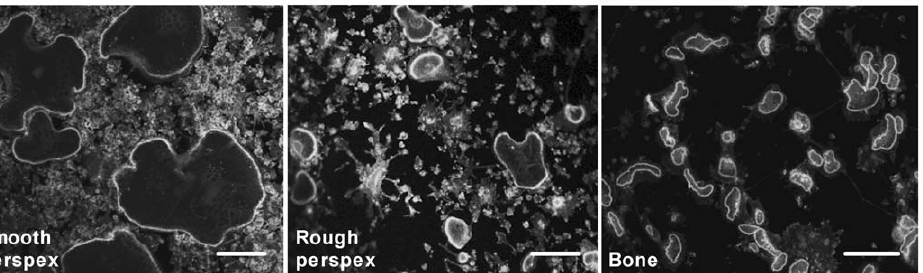
Figure 3. The effect of substrate roughness on the morphology of podosome belts. Bone marrow-derived osteoclasts were sedimented in MEM/BSA onto Perspex that had been coated with vitronectin (50 m g/ml), or bone slices. Osteoclasts were incubated for 5 hours in MEM/BSA with M- CSF (50 ng/ml), RANKL (30 ng/ml) and IL-1 a (10 ng/ml) on uncut Perspex surfaces (smooth), or on the surface of Perspex cut with the same saw as that used to prepare bone slices (rough). Phalloidin staining. Scale bars =50 m m.